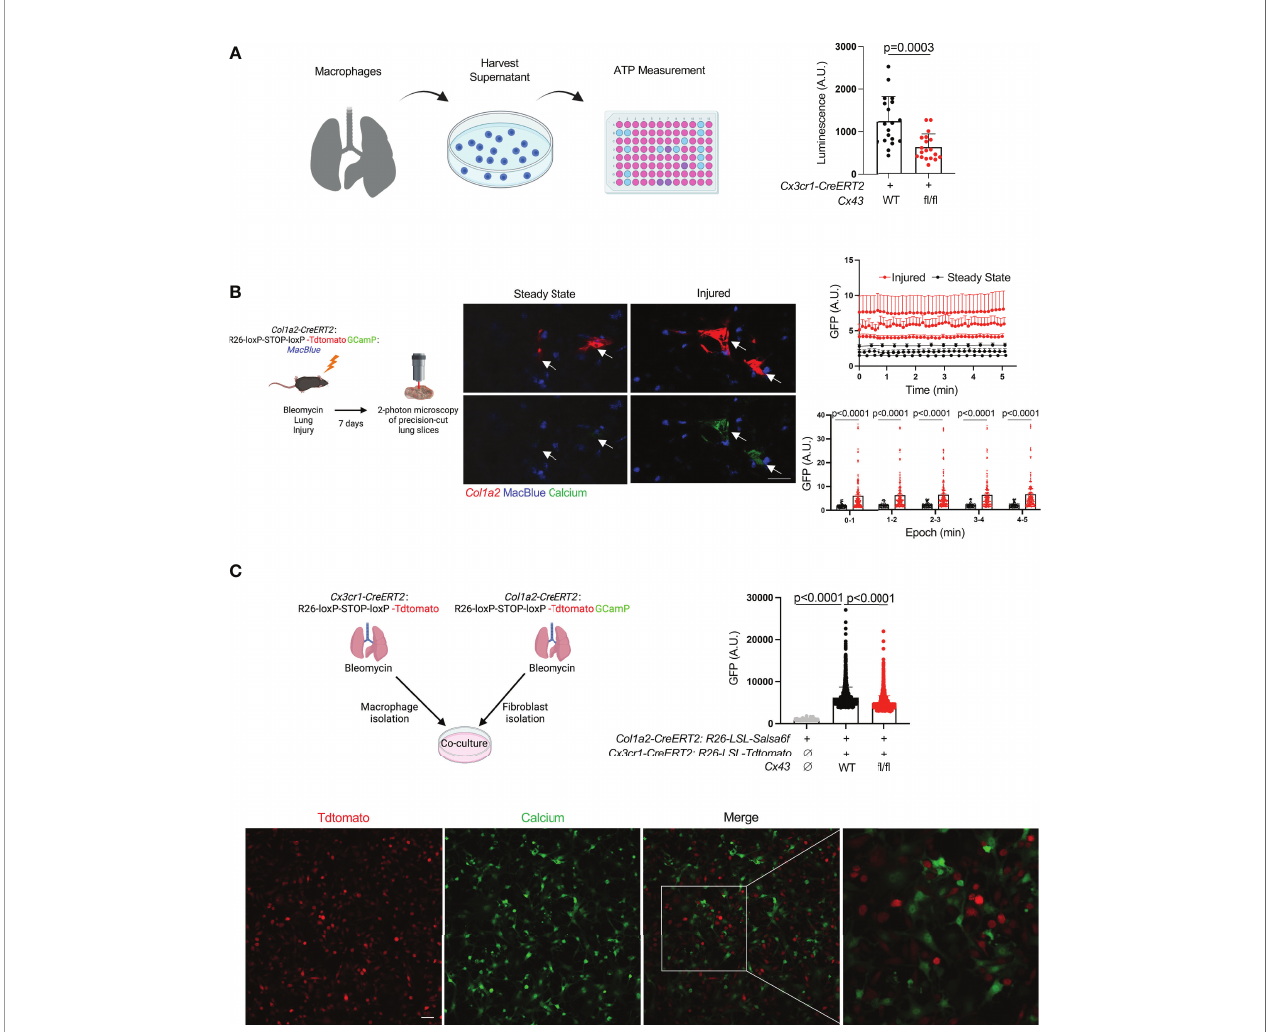
FIGURE 1 | Lung moMac Cx43 is required for ATP ef fl ux and fi broblast cytosolic calcium in co-culture. (A) ATP measured in conditioned media after 24 hours of culture of tdTomato+ cells sorted from tamoxifen-induced Cx3cr1-CreERT2: LSL-tdTomat o mice with or without homozygous fl oxed Cx43 alleles. Quantitation is for n=3 mice in each group, and points in the graph represent all technical replicates. P value is for Student ’ s unpaired two-tailed t-test. (B) Representative images of two-photon calcium imaging of precision-cut lung slices taken from Col1a2-CreERT2: R26-LSL-Salsa6f(tdtomato-GCaMP): MacBlue mice at steady state or 7 days after bleomycin injury. Arrows indicate fi broblasts. Scale bar= 50 m m. Plots are for time-lapse imaging of individual slices from n=3 mice per condition (10-18 individual cells per fi eld of view for injured and 5-11 individual cells per fi eld of view for steady-state slices). Upper plot shows mean cytosolic GFP fl uorescence for individual fi broblasts (as marked by tdTomato) for each slice across time; lower plot presents the same data as mean GFP fl uorescence for aggregate data within 5 consecutive 1-minute time periods. P values are for 2-way ANOVA followed Sidak ’ s multiple comparison test. (C) Confocal calcium imaging of macrophages sorted from tamoxifen-induced Cx3cr1-CreERT2: R26-LSL-tdtomato mice and co-cultured with fi broblasts isolated from tamoxifen-induced Col1a2-CreERT2: R26-LSL- Salsa6f(tdtomato-GCaMP) mice. A representative fi eld of view is shown, and the right-most image magni fi es the indicated area in the merge. Scale bar= 50 m m. Quantitation is for co-culture with WT or Cx43 KO macrophages, or for fi broblasts alone, for n=3 mice in each condition, and points in the graph represent individual cells. P values are for one-way ANOVA followed by Sidak ’ s multiple comparison